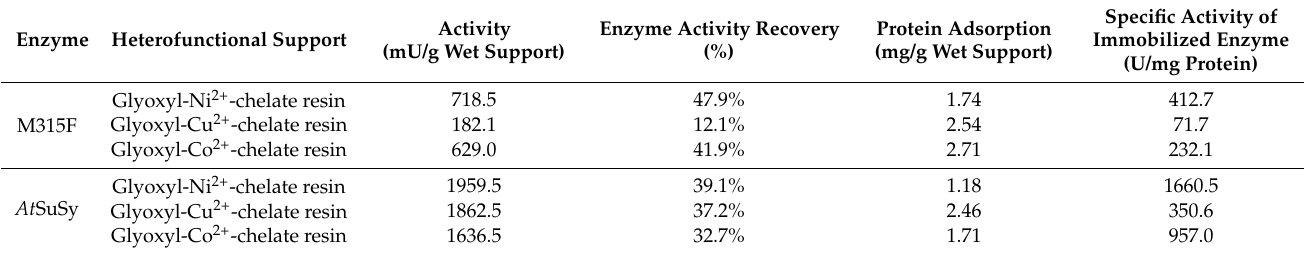
Table 1. Heterofunctional support on the effect of adsorbed individual M315F and At SuSy.